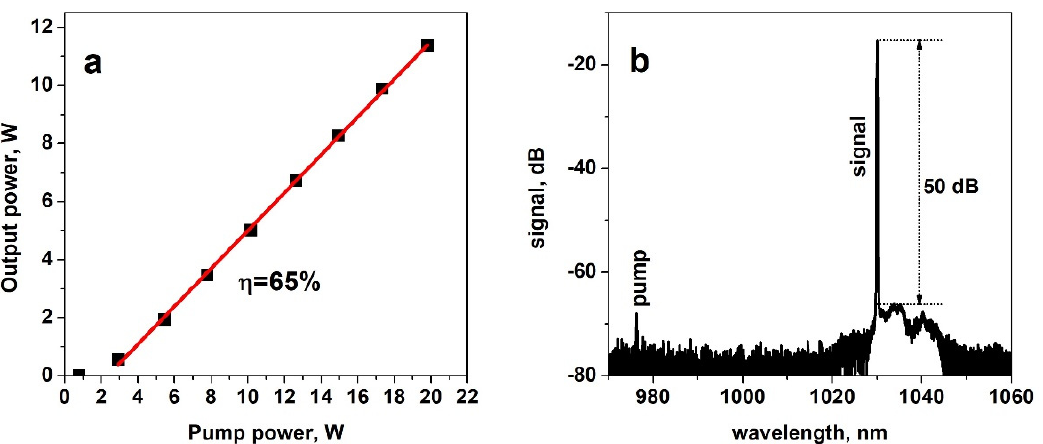
Figure 5. Dependence of the output power on the pump power ( a ) and the output spectrum measured at the highest pump power ( b ).